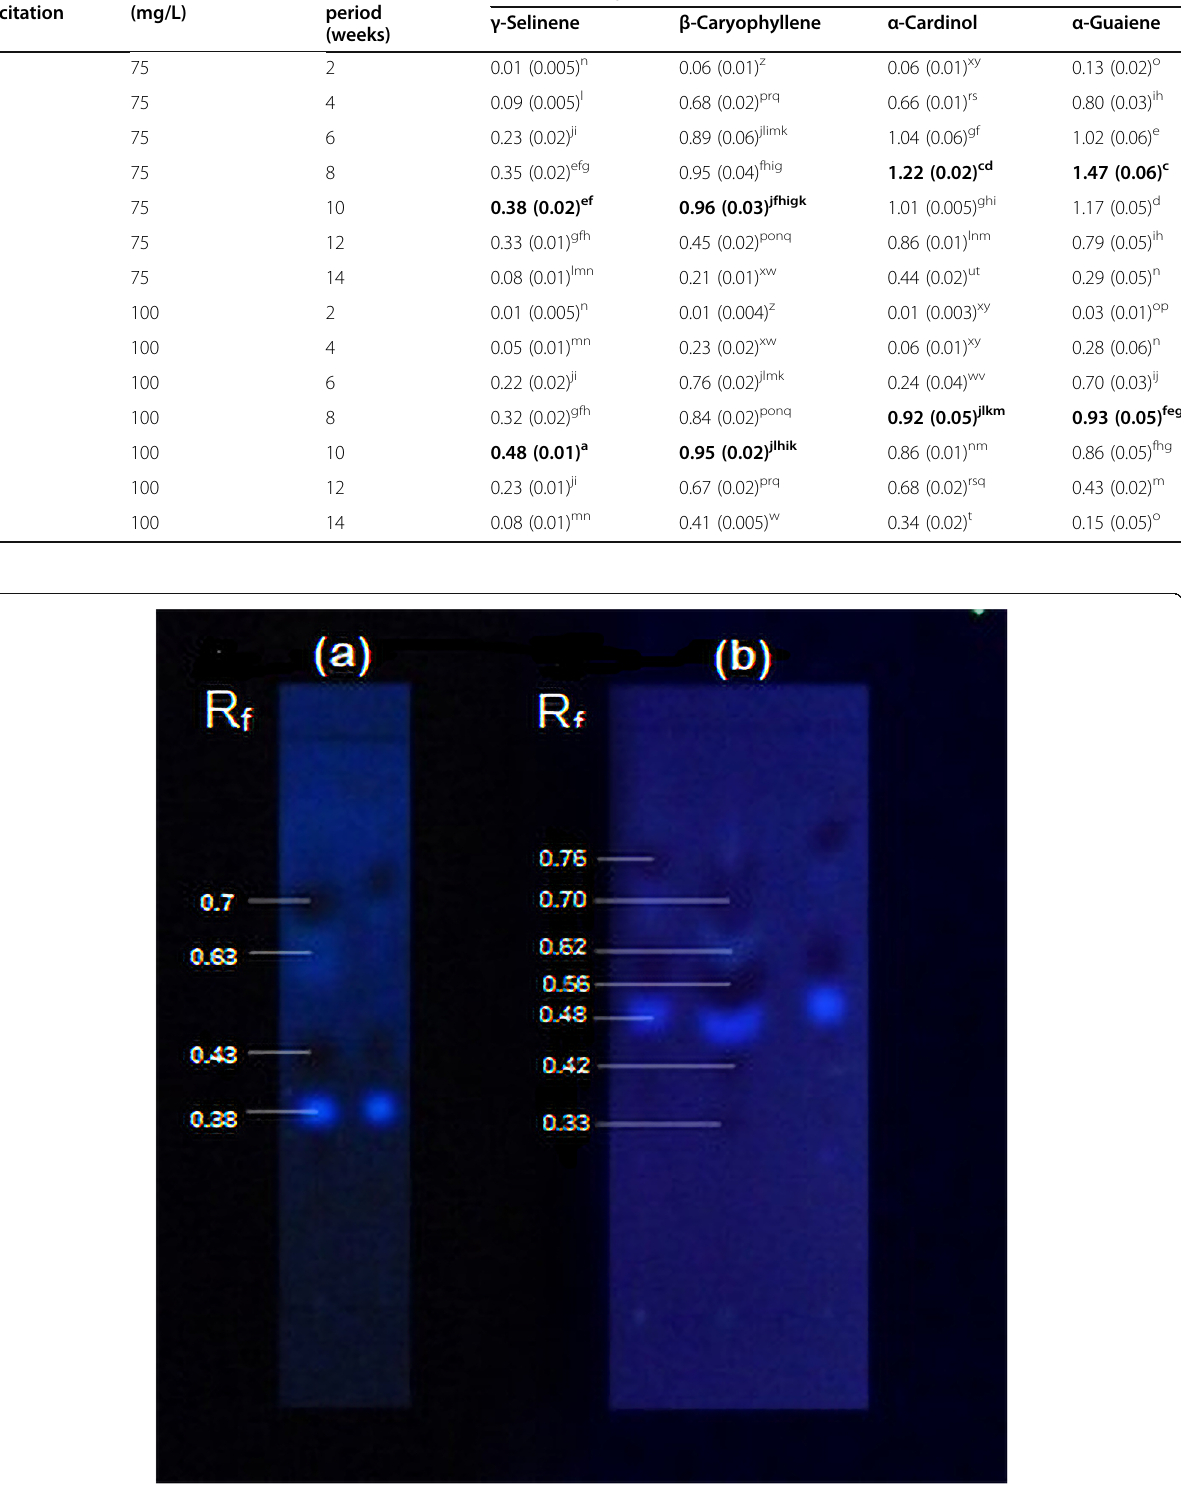
Table 3 Effect of biological elicitors on Gyrinops walla calli (Continued) Type of elicitation